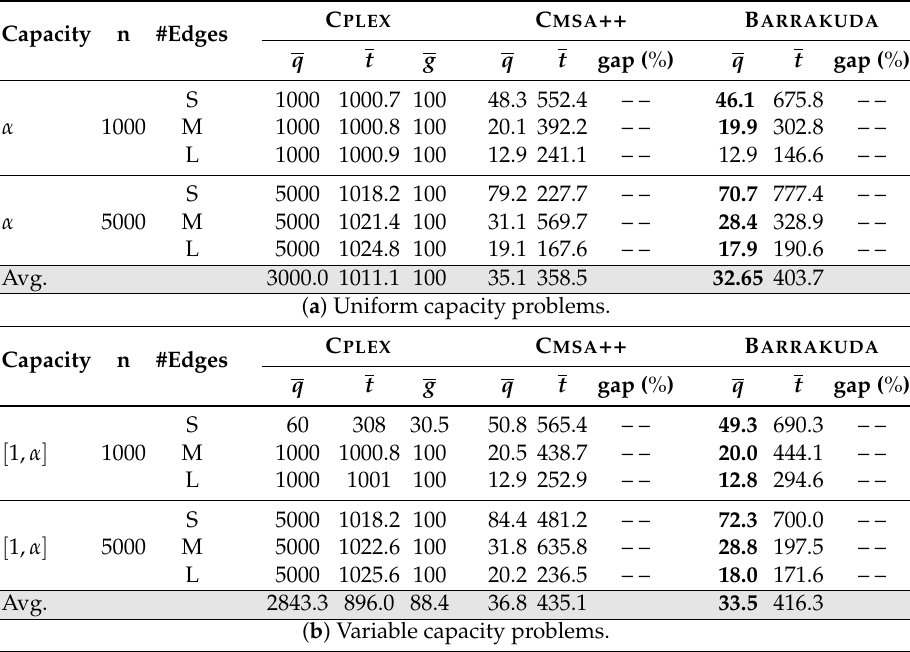
Table 9. Experimental results for the random graphs from the new set of large problem instances.